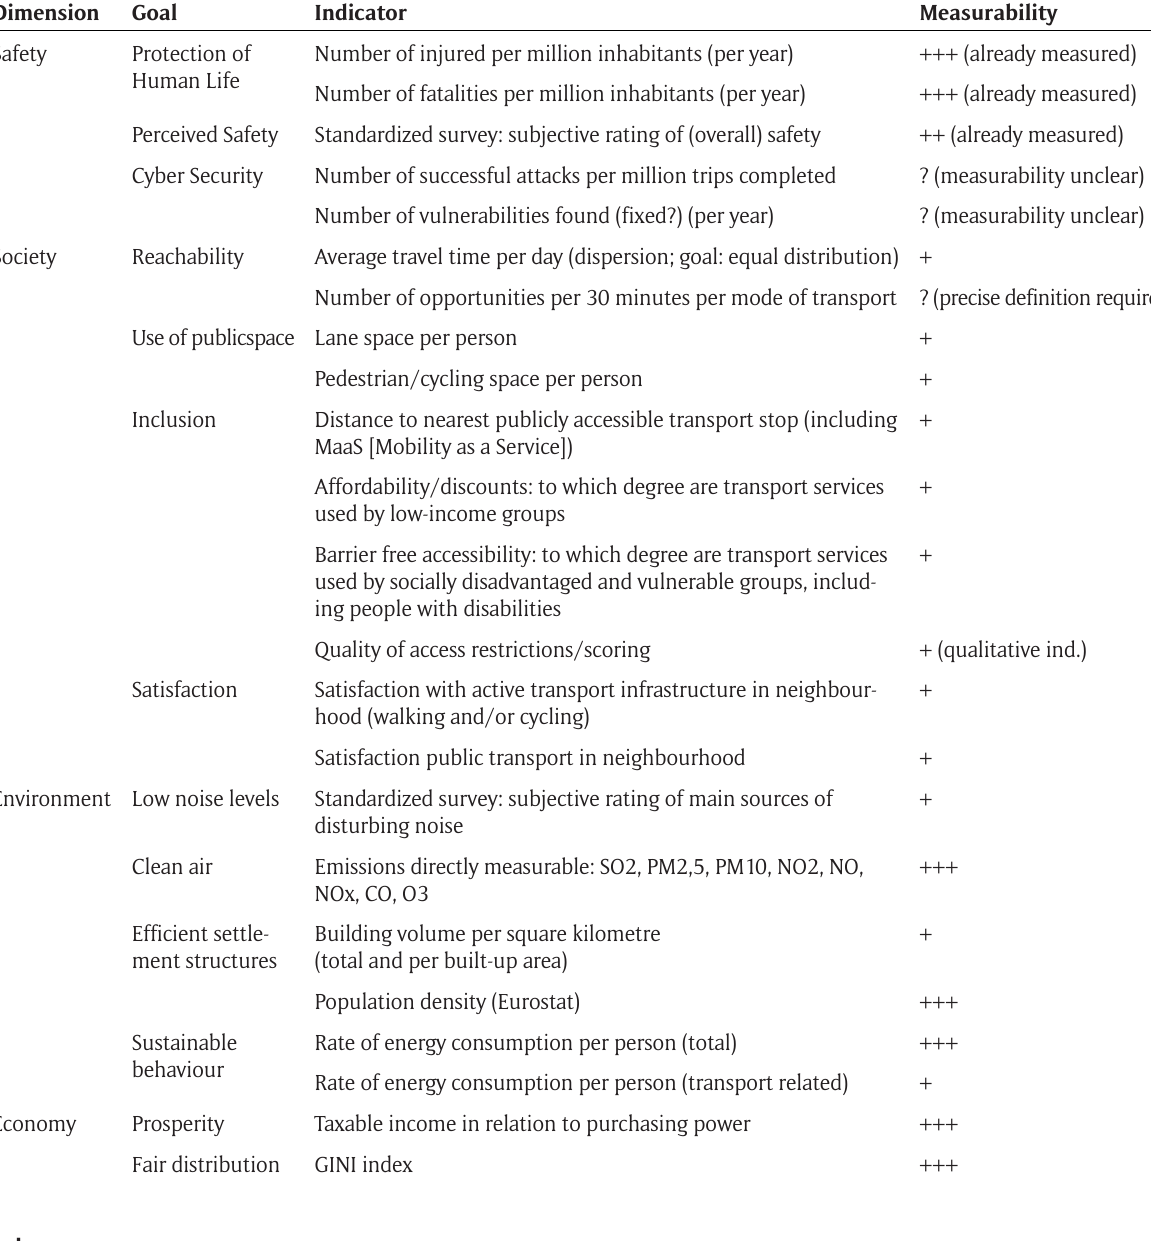
Table 3: Urban development goal areas and indicators, including assessment of measurability (Zach, Millonig and Rudloff, 2020 p36).